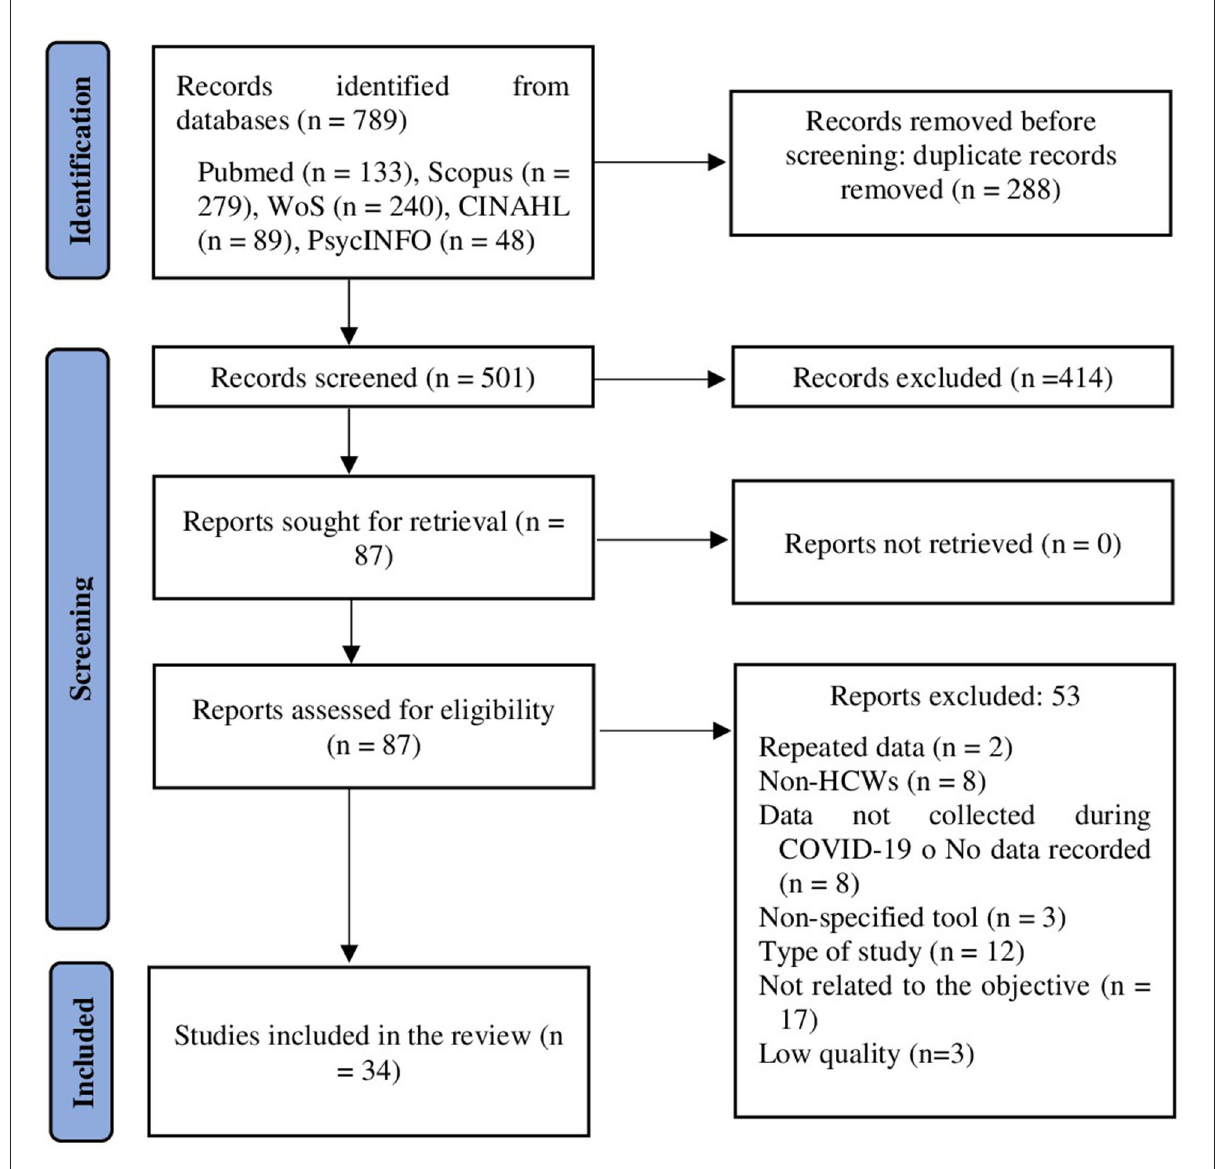
FIGURE1 Identification of studies via databases (PRISMA flow